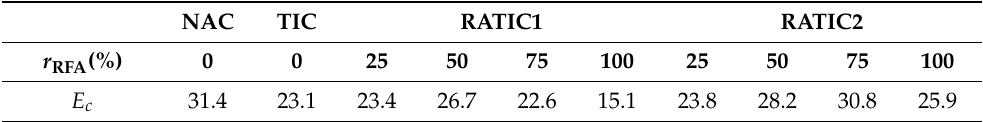
Table 7. Elastic modulus of RATIC